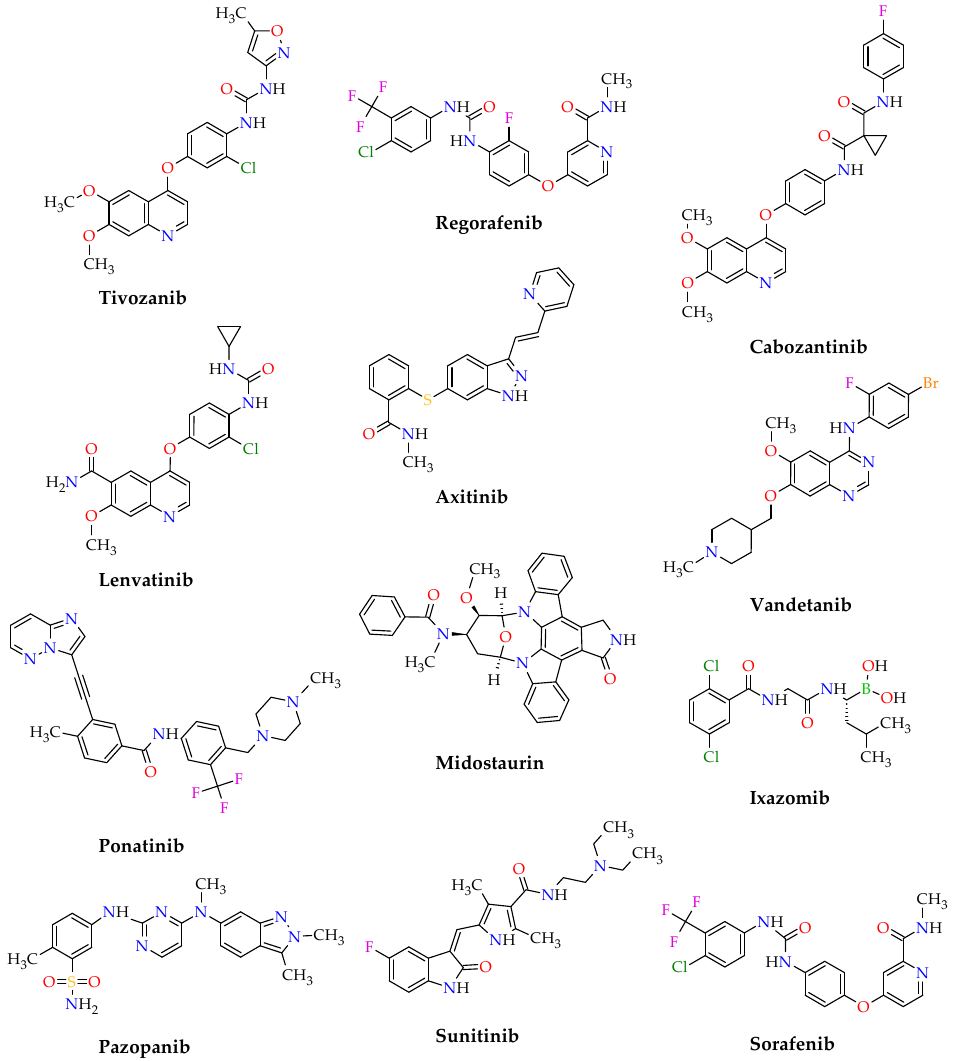
Figure 1. Small-molecule inhibitors with anti-VEGFR activity for the treatment of various types of cancer.